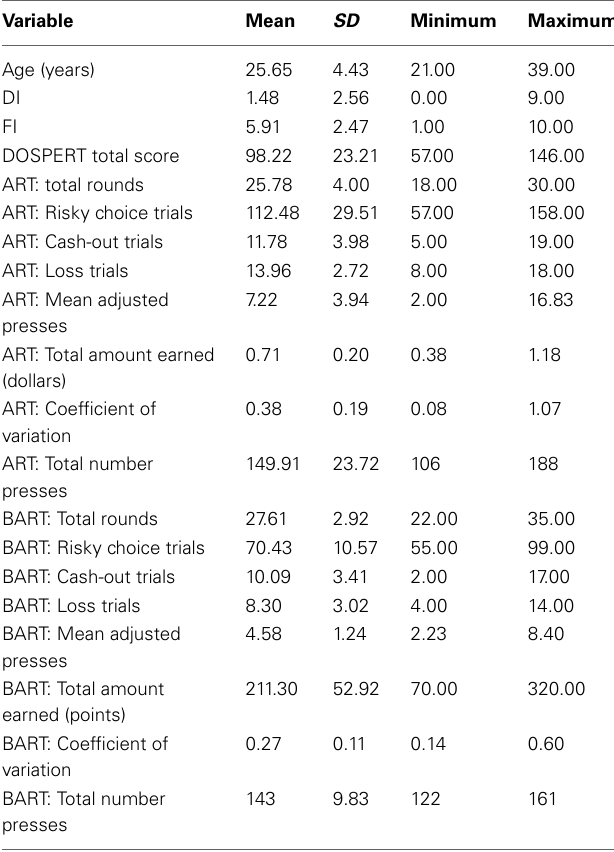
Table 1 | Descriptive statistics of sample demographics and study measures.